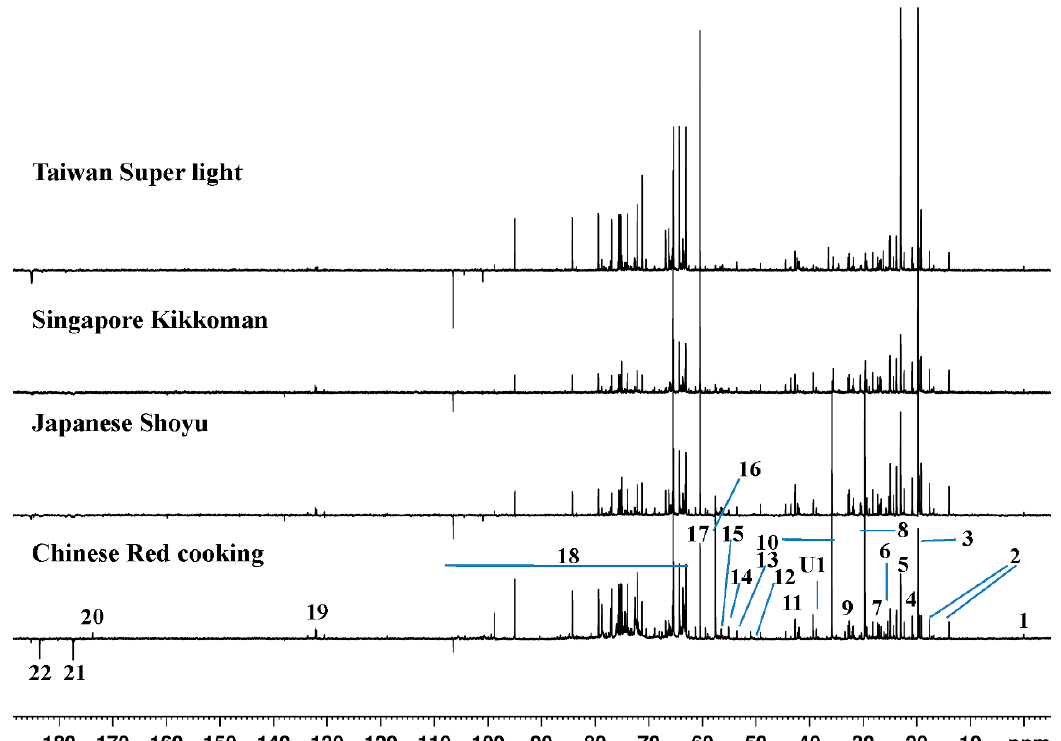
Figure 1. Representative 13 C-NMR spectra of four types of Asian soy sauces viz. Chinese red cooking, Japanese shoyu, Singapore Kikkoman and Taiwan super light. Peaks: 1: trimethylsilyl propanoic acid